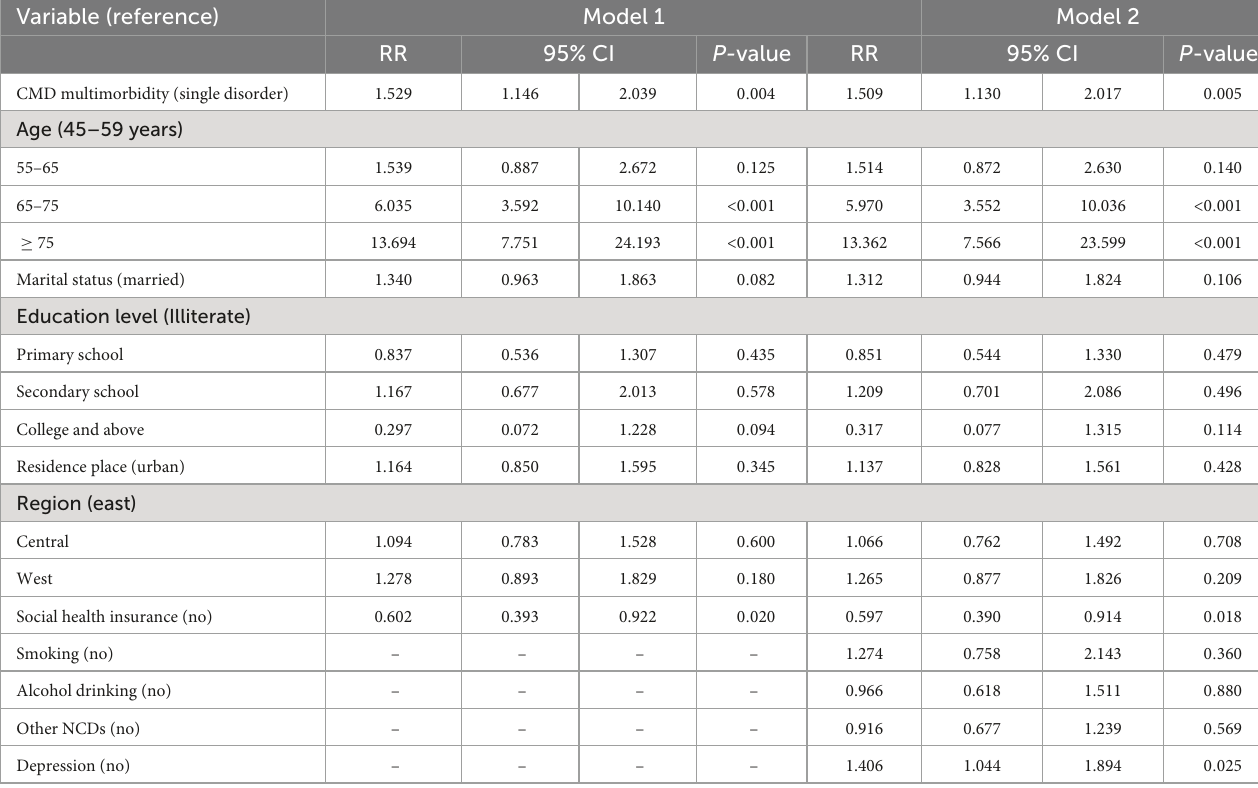
TABLE 3 Association of CMD multimorbidity with all-cause death. Variable